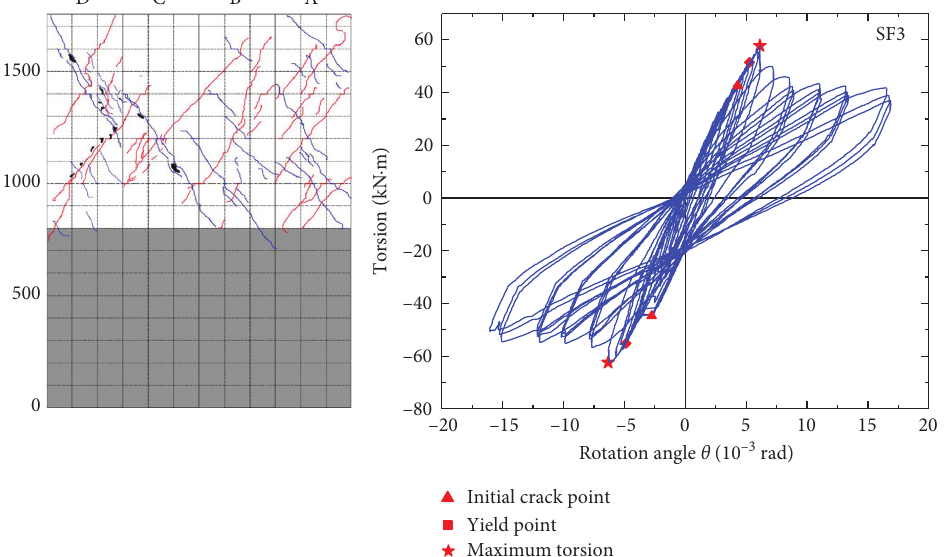
Figure 12: Damage and hysteresis curves of specimen SF3.